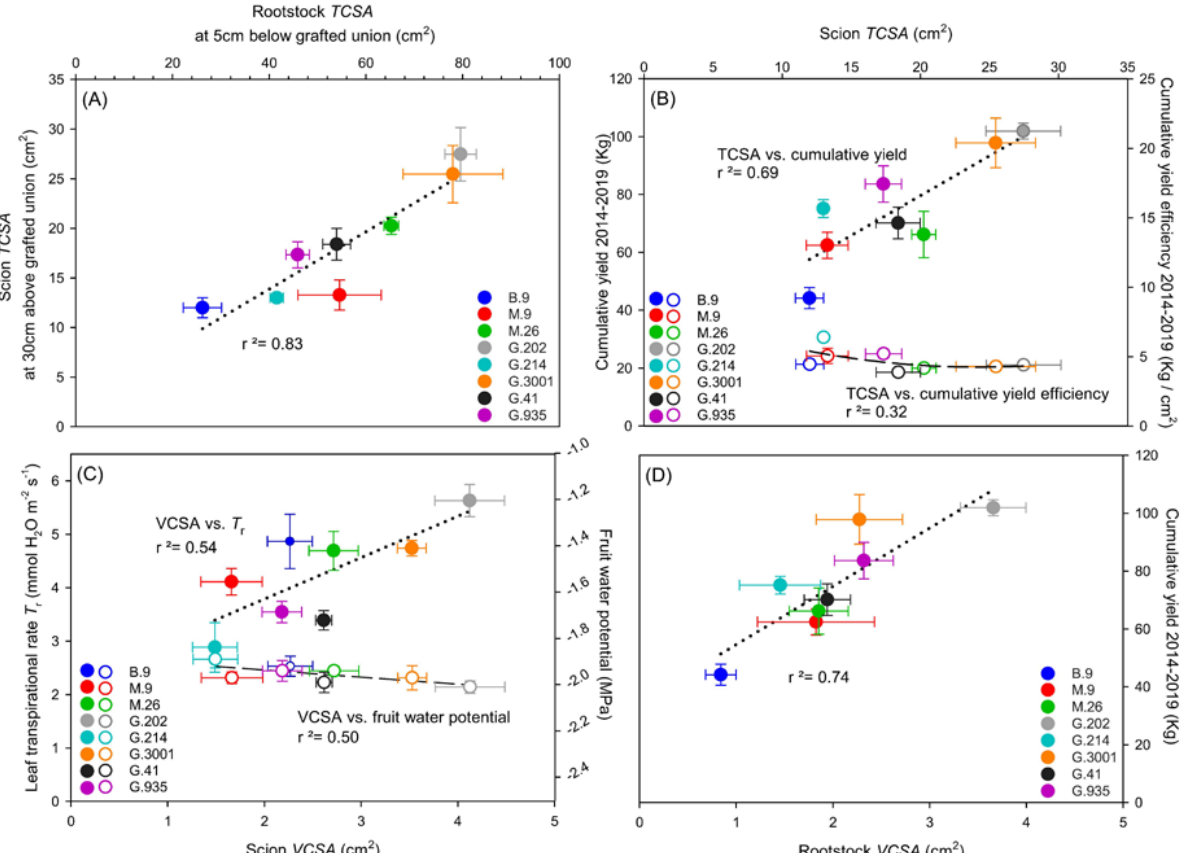
Figure 7. Vigor and xylem vessel cross-section area ( VCSA ) of rootstock and scion in relation to water status and yield efficiency of Honeycrisp scion on eight rootstocks. ( A ) Relation between rootstock trunk cross-section area ( TCSA ) and scion TCSA ; ( B ) Scion TCSA in relation to cumulative yield and cumulative yield efficiency; ( C ) Scion VCSA in relation to leaf transpirational rate T r and fruit water potential Ψ fruit ; ( D ) Relation between rootstock VCSA and cumulative yield. Data are shown as mean ± standard error. Regression analysis was conducted to compute the coefficient of determination r 2 for each pair of parameters (scion TCSA vs. cumulative yield efficiency: polynomial model; other relations: linear model).